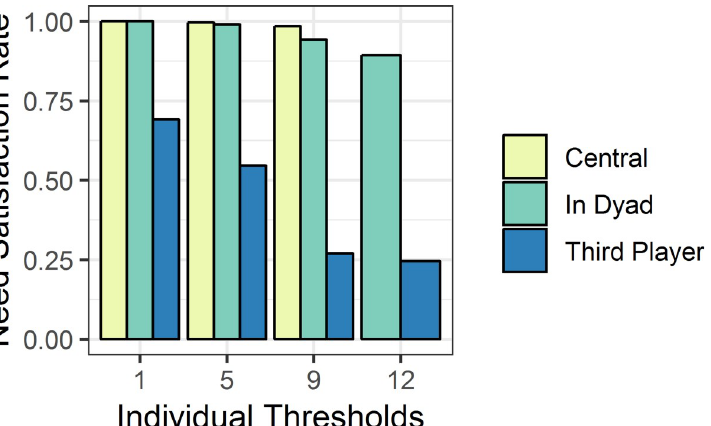
Fig 2. NSR-I by position over individual thresholds. The x-axis shows individual need thresholds, the y-axis the NSR-I for individual observations. The central player never was assigned a threshold of 12 points (see Table 1 for list of thresholds). All scenarios with sums of thresholds smaller than the resource of 24 points are included. Columns are split by network position (central or peripheral) and by the “role” (in dyad or third player) a participant assumed in each period. The central player could not be excluded from agreements. A peripheral player either became the agreement partner, by being part of the dyad, or she became the third player, by being excluded from the agreement. Exclusion from the agreement does not imply that this peripheral player did not receive any payoffs from this period, because the agreeing dyad may allocate some share to her.